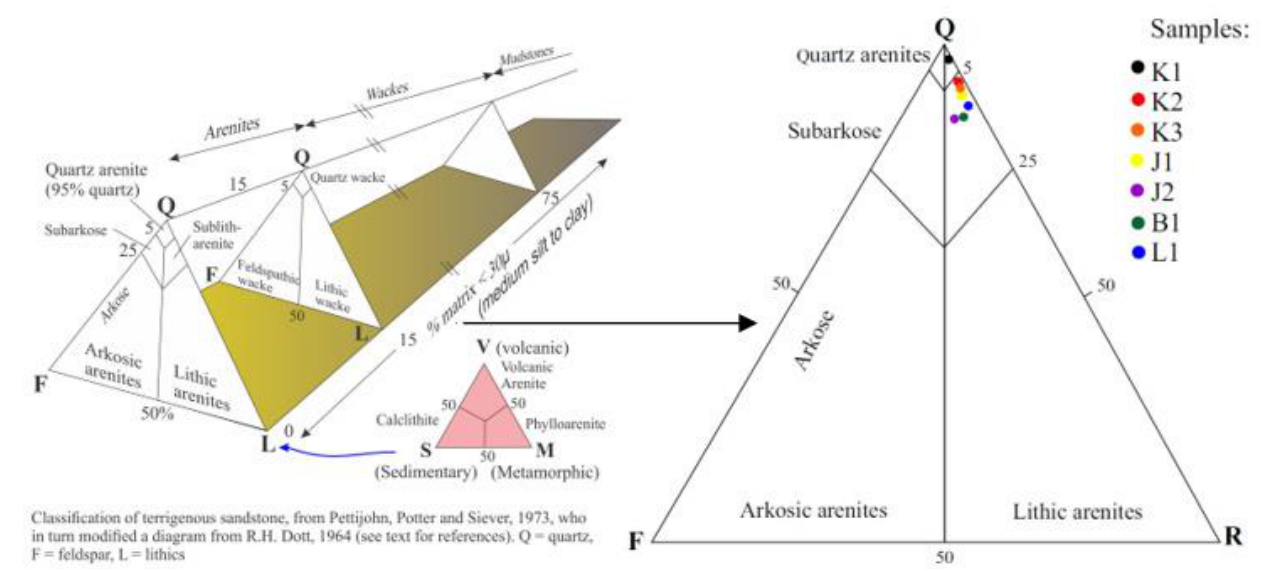
Figure 16. Classification of tested sandstones according toFolk triangle [24,25].